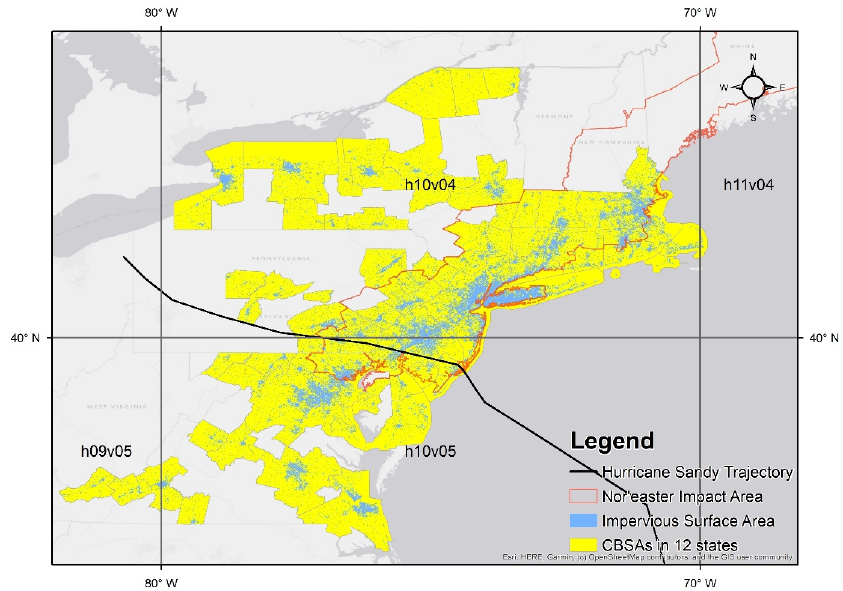
Figure 1. VIIRS image tiles covering the study area.